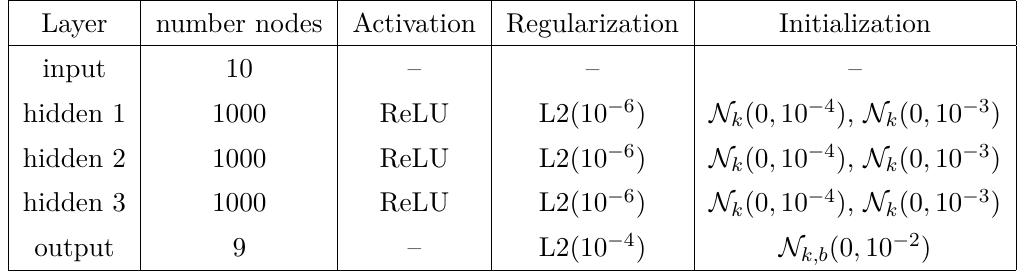
Table 3 . Neural network architecture for each ‘patch’ neural network that approximates the CY